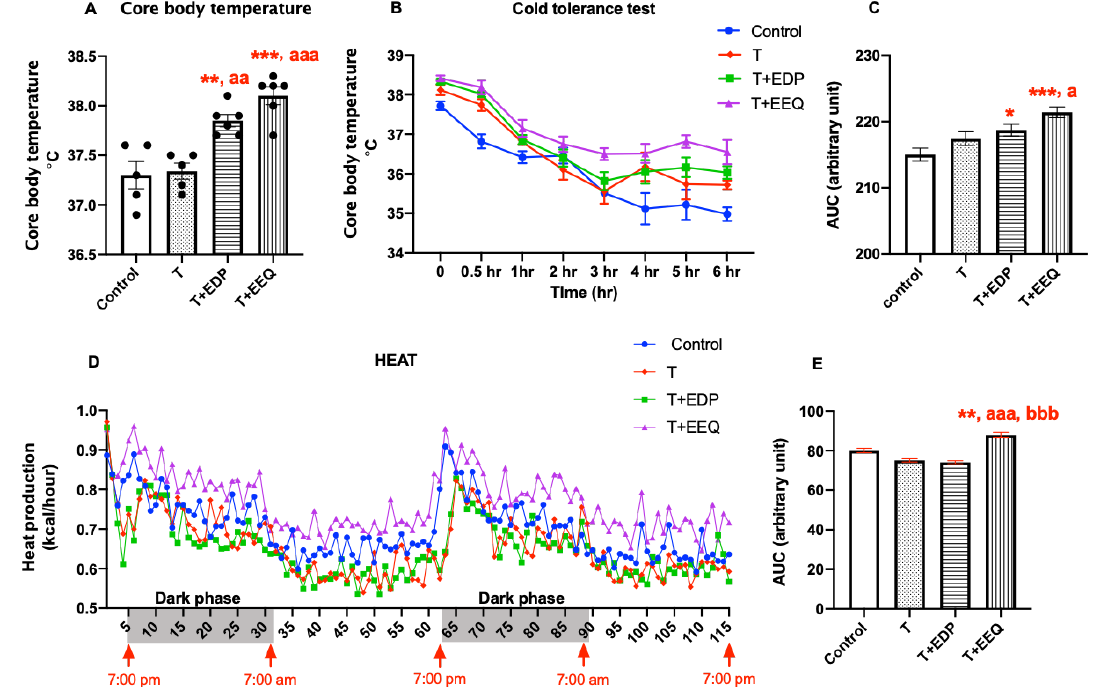
Figure 3. 17,18-EEQ or 19,20-EDP combined with t -TUCB delivered via mini osmotic pump increased thermogenesis in diet-induced obesity. Male C57BL/6J mice fed a high-fat diet (45% kcal from fat) were treated with t -TUCB alone (3 mg/kg/day) or combined with 19,20-EDP (0.05 mg/kg/day) (T + EDP) or 17,18-EEQ (0.05 mg/kg/day) (T + EEQ) by osmotic minipump implantation for 6 weeks, as described. Core body temperature ( A ), cold tolerance test and the area under the curve (AUC) ( B , C ), and heat production and the area under the curve (AUC) ( D , E ) after 6 weeks of minipump implantation are shown. Data = the mean ± SEM ( n = 5 – 6) ( A – C , E ), or only the mean ( n = 5 – 6) ( D ). *, **, and *** = p < 0.05, p < 0.01, and p < 0.001 compared to the controls, respectively. a , aa , and aaa = p < 0.05, p < 0.01, and p < 0.001 compared to the T group, respectively. bbb = p < 0.001 compared to the T + EDP group.